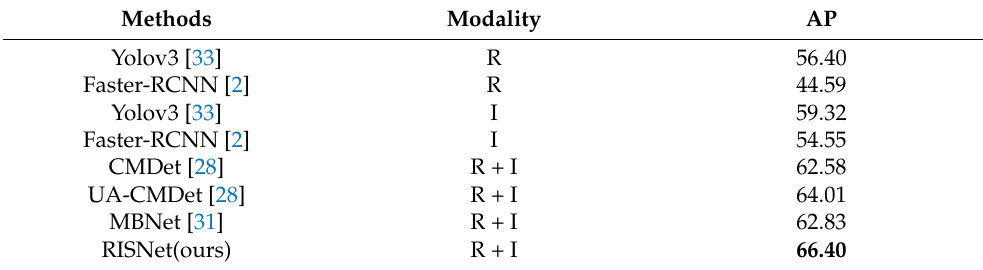
Table 1. Comparison results of different algorithms, the best AP indicators are generally black.